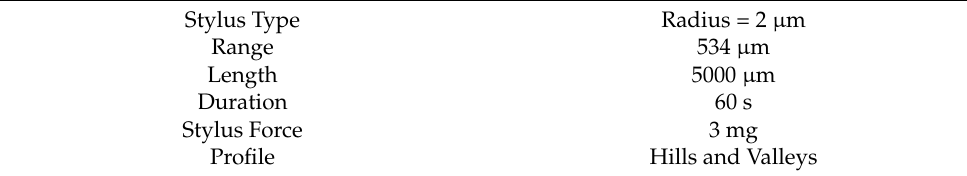
Table 3. Line profilometry